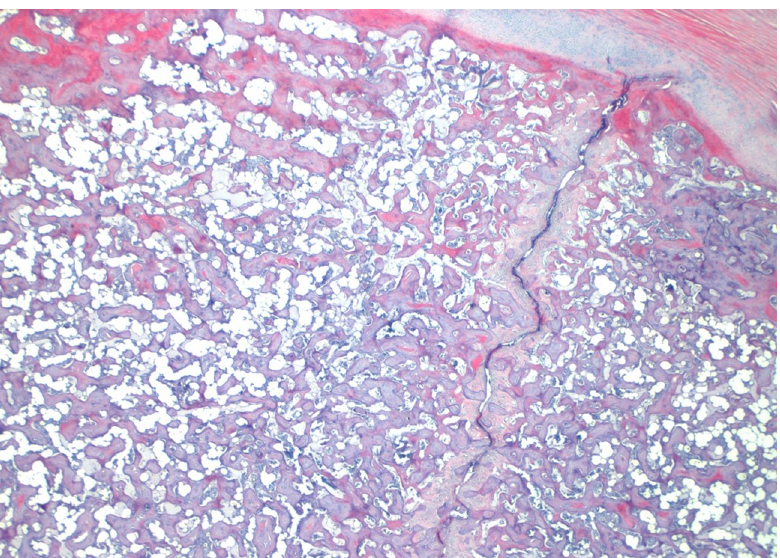
Fig 8. Typical un-branched fracture line with minimal repair processes (HE